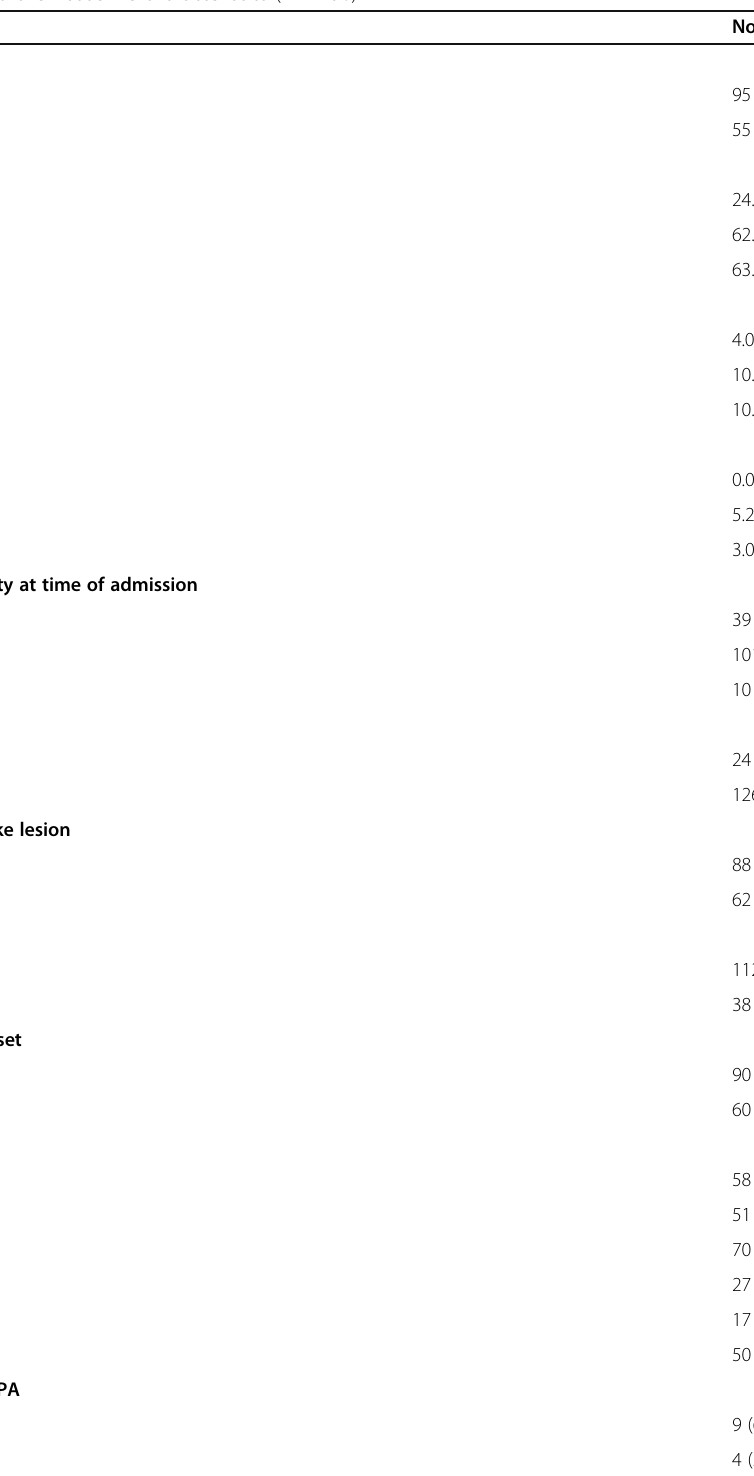
Table 1 Patients demographic data and their baseline characteristics ( n =